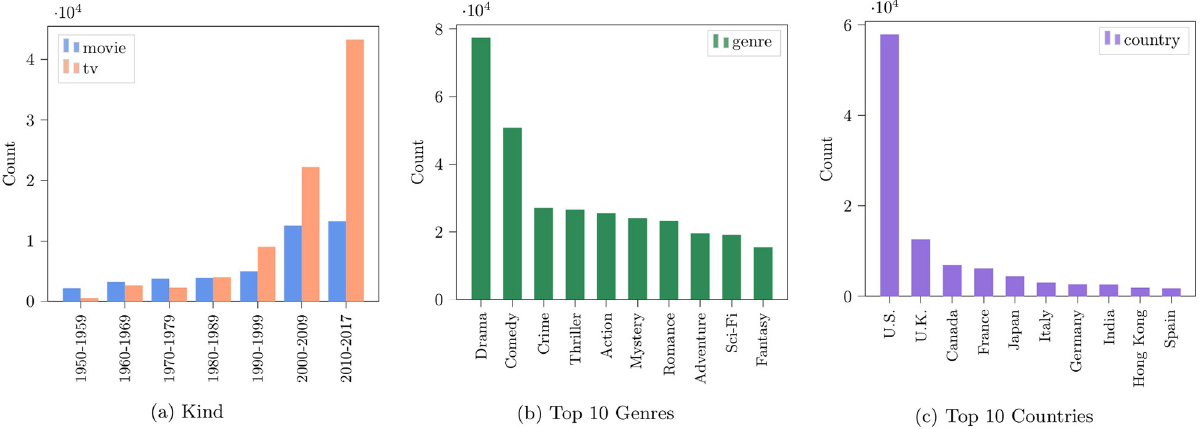
Fig 2. Descriptive statistics of the OpenSubtitles dataset. a) Distribution of IMDb title type (movie/TV) by year. b) Distribution of the top ten genres. c) Distribution of the top ten production countries. We use the OpenSubtitles dataset between the years 1950 and 2017.